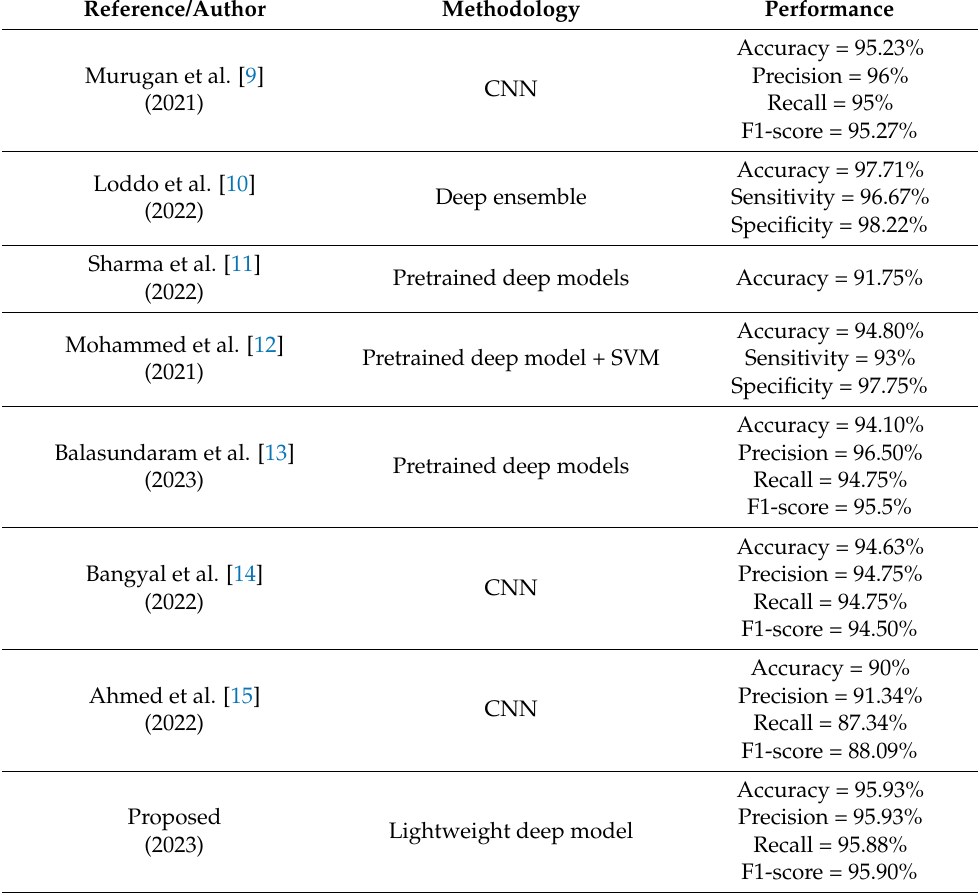
Table 7. Comparison between the proposed model with other previous model for multi- classification